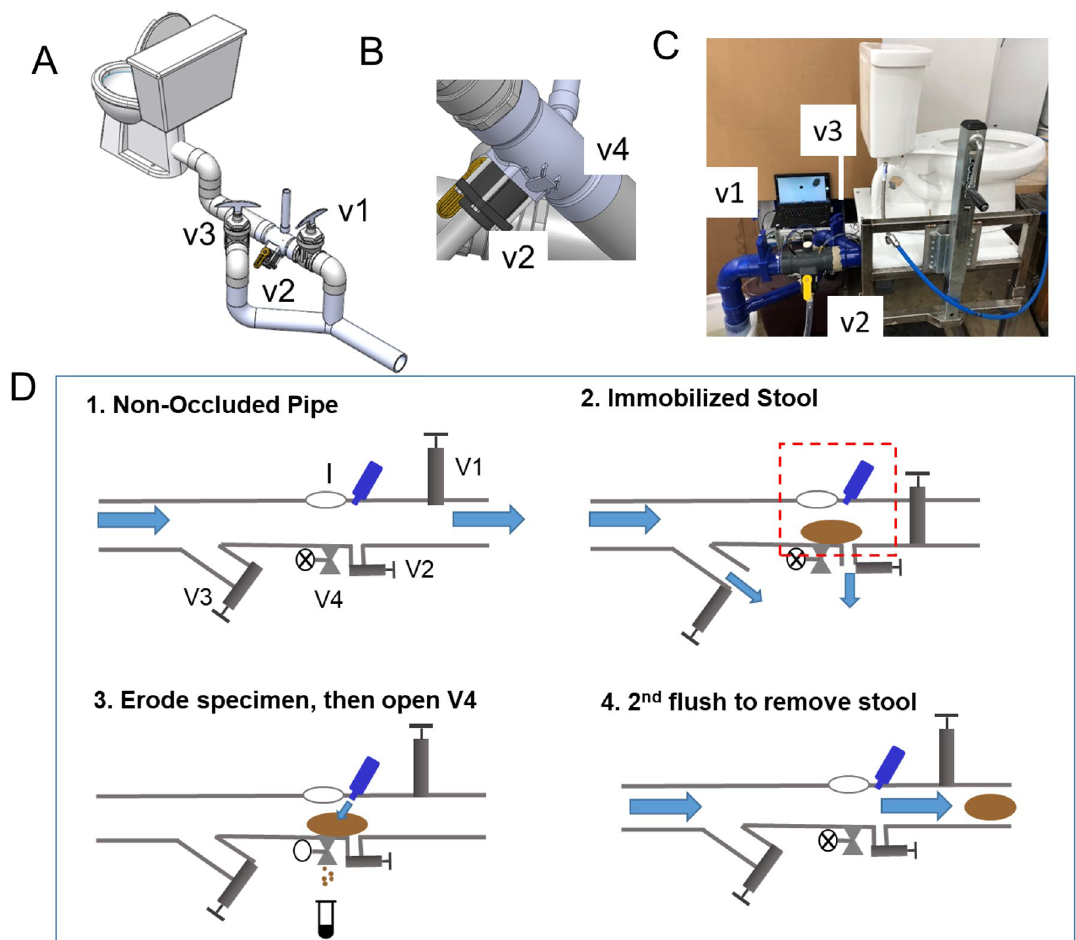
Figure 1. ( A ) An illustration of the prototype connected to a rear exit toilet. ( B ) Close-up view of the bottom part of the prototype shown in ( A ). ( C ) Picture of the prototype connected to a bottom exit toilet with endoscope connected to a laptop for image collection. ( D ) Operating principle of the system including 4 valves, V1 through V4, and I = inspection and venting port. 1. The valve position for regular operation of the toilet, blue arrow indicates water flush direction from toilet to sewer line. 2. The stool is immobilized in the stool area (red dashed rectangle). 3. A spray-jet of buffer erodes specimen collected by gravity through V4. 4. The stool is flushed to